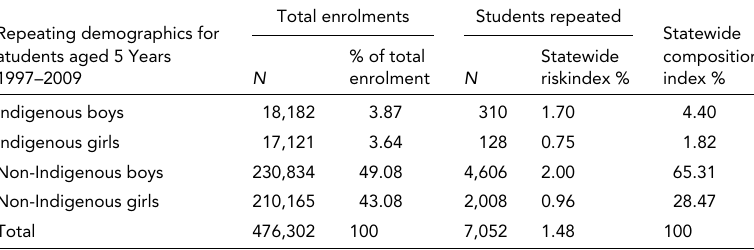
Total enrolments Students repeated Repeating demographics for